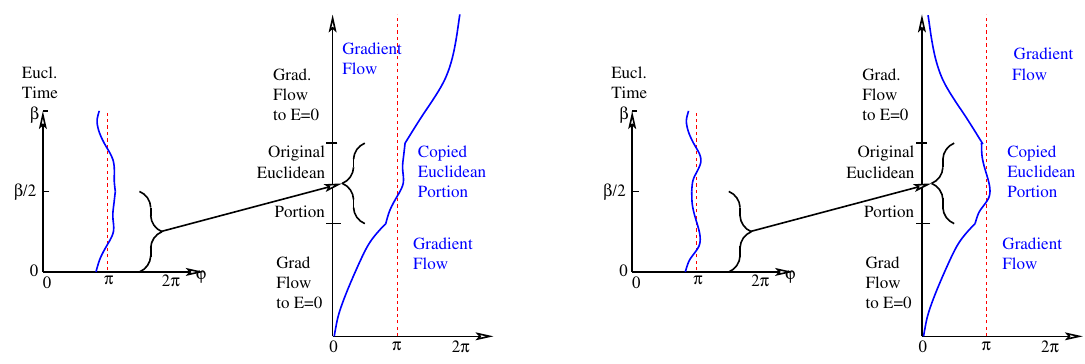
Figure 4 . Cartoon of how two configurations would be evaluated using the gradient-flow approach described in the text. A segment of a Euclidean simulation, from t = 0 to t = β/ 2 , is cut out of the simulation, and the starting/ending configurations are gradient-flowed to a zero-energy state. The whole path (zero-energy to t = 0 to t = β/ 2 to zero-energy) either has ϕ change by ± 2 π (left) or by 0 (right); in the former case it counts as a